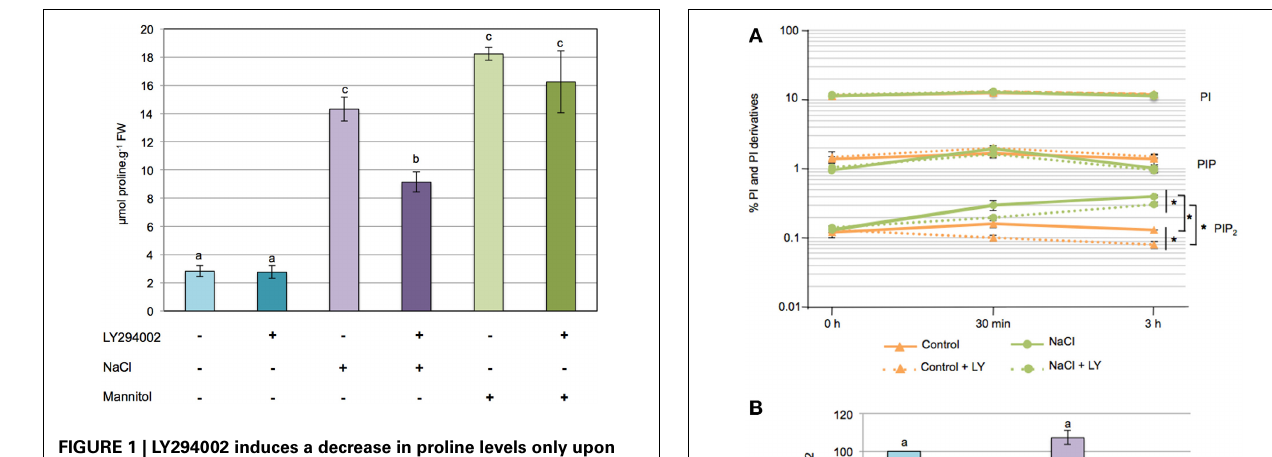
FIGURE 1 | LY294002 induces a decrease in proline levels only upon salt stress in Arabidopsis. Twelve-days-old seedlings grown on 0.5 × MS solid medium were transferred to 0.5 × MS liquid medium for treatments. Plants were pre-incubated for 1h with 100 µ M LY294002 or with the same amount of DMSO as a control, and then stressed for 24h with either 200mM NaCl or 400mM mannitol supplemented with 100 µ M LY294002 ( + ) or with the same amount of DMSO as a control ( − ). The results shown are means ± SD of four independent samples. Letters indicate statistical differences in proline level depending on treatment conditions (Two-Way ANOVA test, P < 0 . 05). FW, fresh weight.